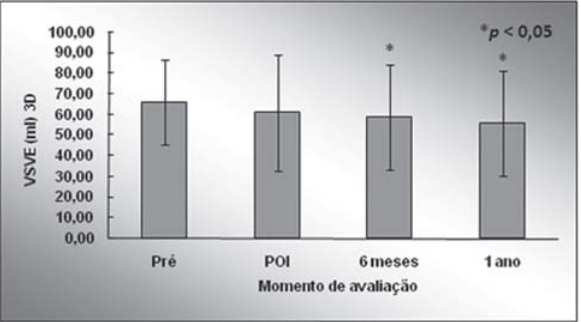
Fig. 8. Evolução do volume diastólico final do ventrículo esquerdo (VDVE) durante o estudo. Observamos redução significativa no VDVE entre o momento Pré (pré-operatório) e POI (pós-operatório imediato). Essa redução permanece estável durante o estudo. Valores = média ± desvio-padrão. * P < 0,05 em relação ao